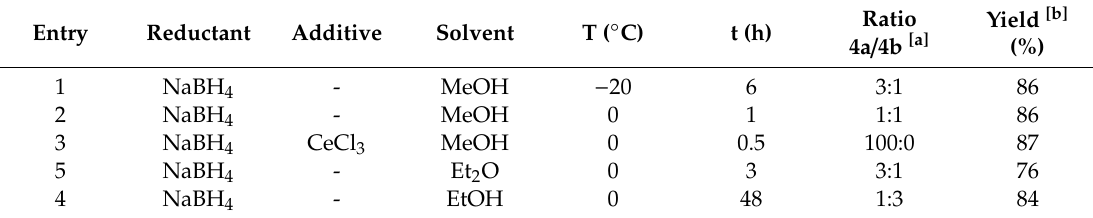
Table 1. Stereoselective reduction of 3 according to Scheme